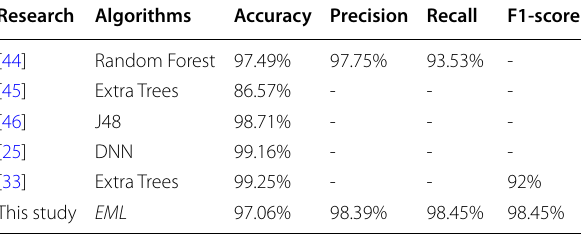
Table 2 Comparative Analysis Research Algorithms